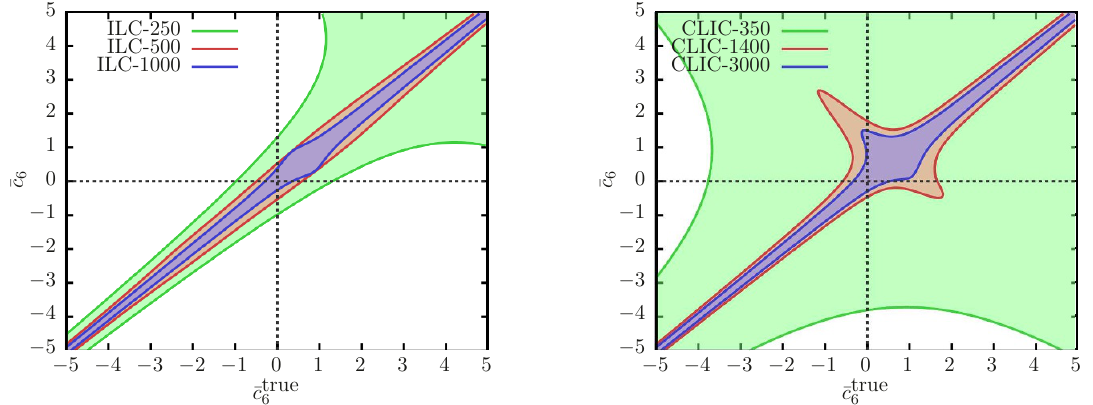
Figure 14 . Combined 2 (cid:27) constraints on (cid:22) c 6 as a function of (cid:22) c true (right) in the Scenario 1 described in the